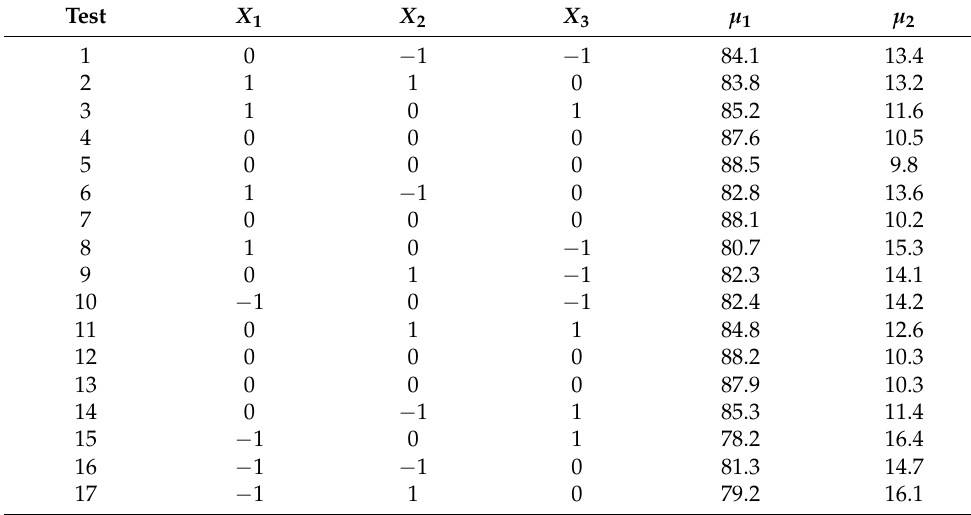
Table 3. The test plans and